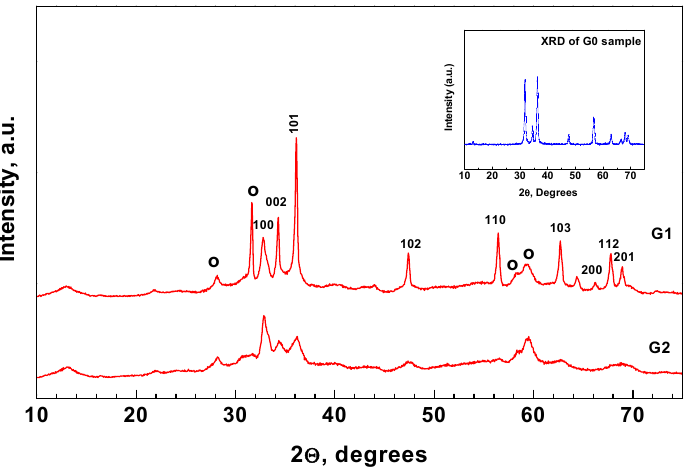
Figure 2. XRD patterns of bio-mediated samples and the reference sample G0 (inset); o -Zinc Hydroxide Carbonate (Hydrozincite) Zn5(OH) 6 (CO 3 ) 2 , PDF 72-1100, Wurtzite-PDF 89-7102. Table 1. Calculated values of the mean crystallite size (D), lattice strain ( ε ), and unit cell parameter (a) of the wurtzite and hydrozincite crystallographic phases.